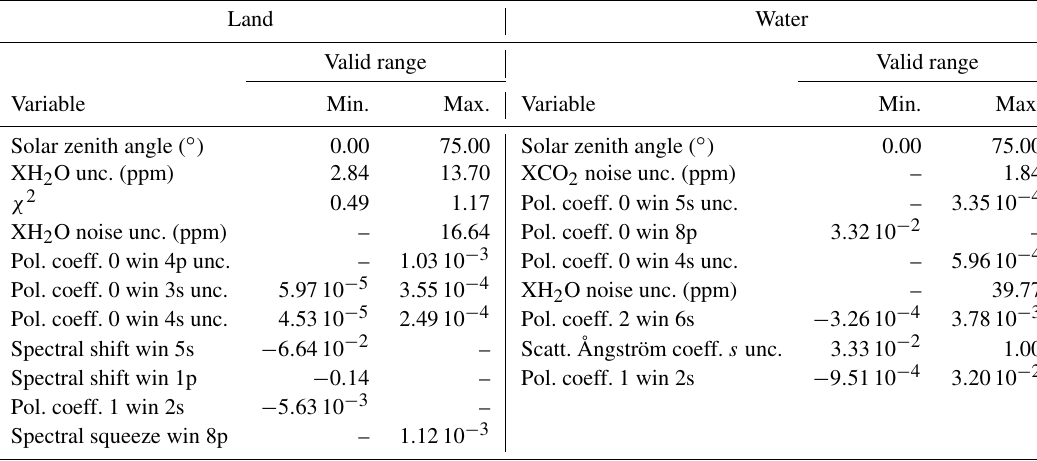
Table A8. XCH 4 Proxy filter variables and limits for GOSAT-2. “–” means that no limit is applied. Except for the solar zenith angle limits, the variables are ordered by their relevance, i.e. by the number of data filtered out.